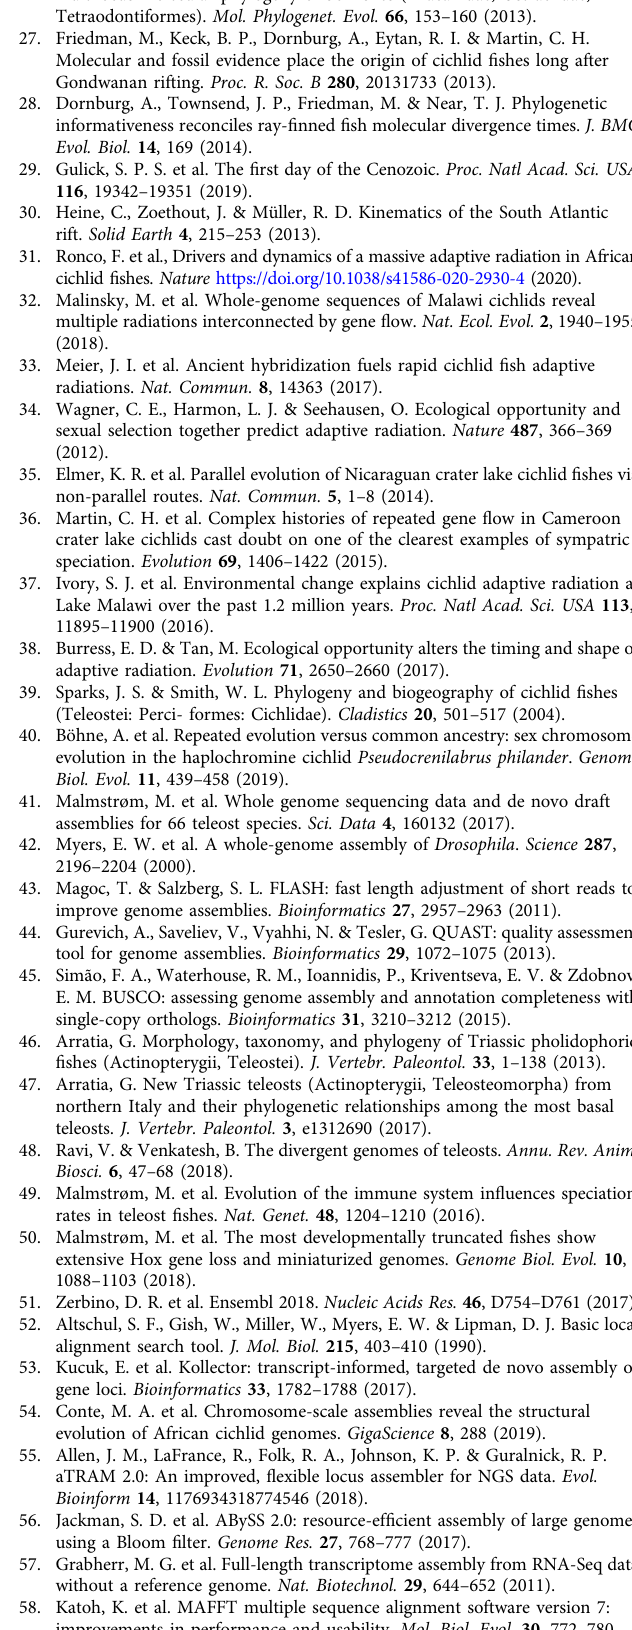
Supplementary Figs. 1 – 4, 6, and 7 have associated raw data available from http:// evoinformatics.eu/continental.htm. Code